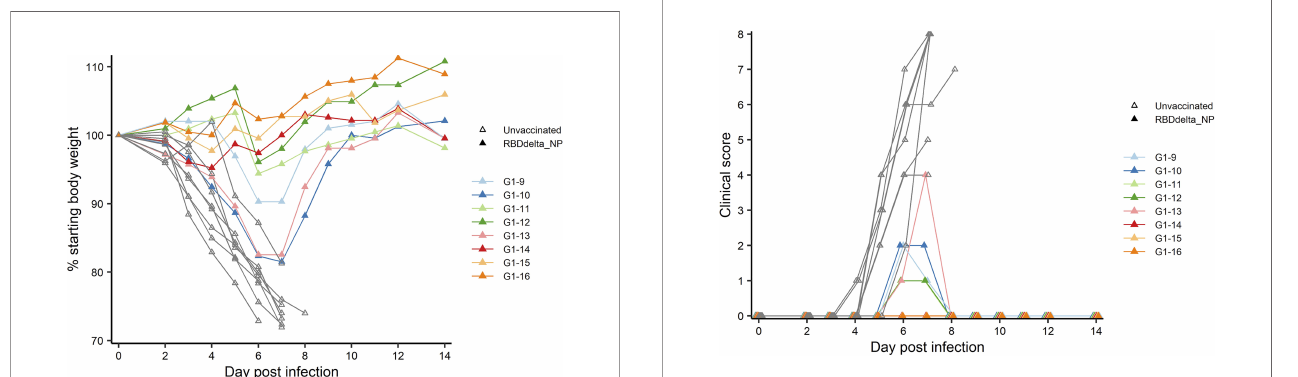
FIGURE 6 | Individual body weight 0-14 dpi: Daily individual weights of infected K18-hACE2 transgenic mice expressed as percentage of starting body weight. Immunized Group 1 (n= 8) is with individual color code and unvaccinated Group 2 (n= 8) is in grey.